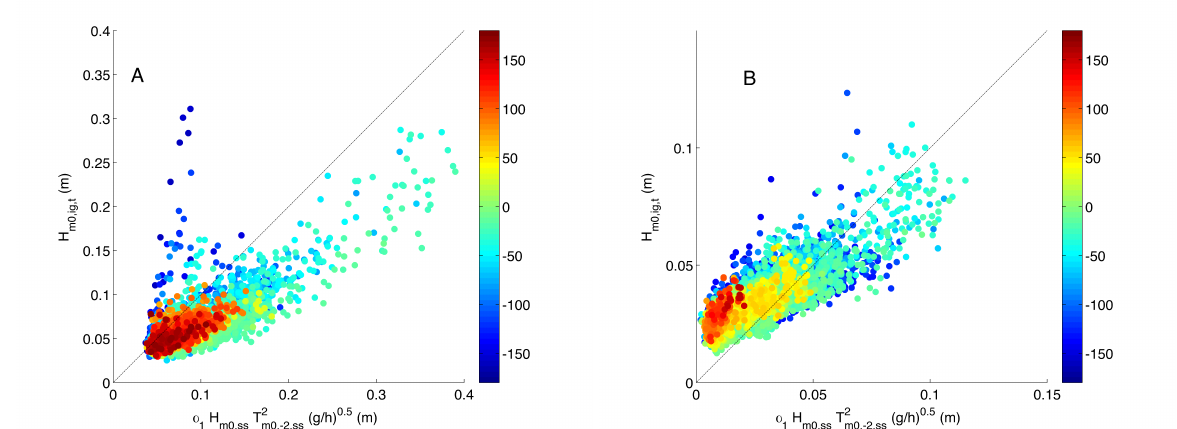
Figure 11. Comparing the measured ( H m 0, ig , t ) and parameterized (Equation (10)) IG wave heights as a function of direction at stations A12 ( A ) and EUR ( B ) using a constant α 1 of 5 e − 4 s − 1 as a reference. Note the difference in scaling for the different stations. Color bars correspond to concurrent sea-swell directions θ ss using the nautical